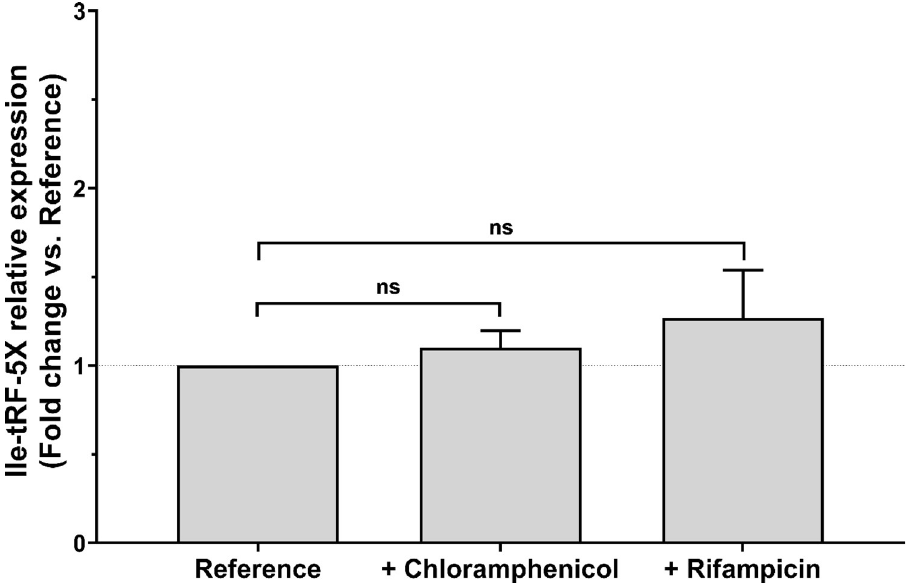
Fig 3. The level of bacterial Ile-tRF-5X level is not modulated by transcription or translation activity. Bacterial mRNA or protein synthesis was inhibited by addition of chloramphenicol or rifampicin, respectively, to cultures of E . coli MG1655 at 37˚C (for details, see S1 Table and S2 Fig ). The level of Ile-tRF-5X was measured by LNA RT-qPCR. A spike-in (UniSp6) and reference genes (23S and/or 16S) were used as control and for normalization. The results are reported in fold change compared to the reference condition. Statistical analysis . Data were calculated from three biological replicate measurements (n = 3; mean ± SD). One-way analysis of variance (ANOVA) and Holm-Sˇı´da´k’s multiple comparisons test (post-hoc test) were used for statistical analysis. Statistically significant differences (fold change vs. reference) are indicated by stars ( � ), � p < 0.05; �� p < 0.01; ��� p < 0.001; ���� p < 0.0001; ns, not